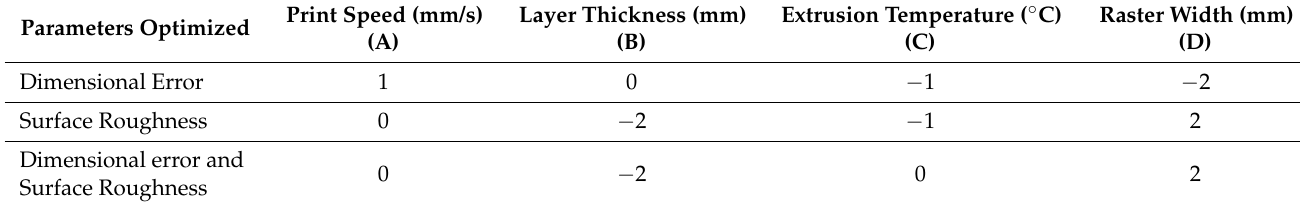
Table 7. Shifted parameter settings for optimizing dimensional error and surface